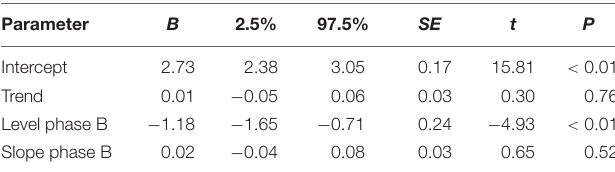
TABLE 2 | Piecewise Poisson-regression table, for case 1 in Figure 2